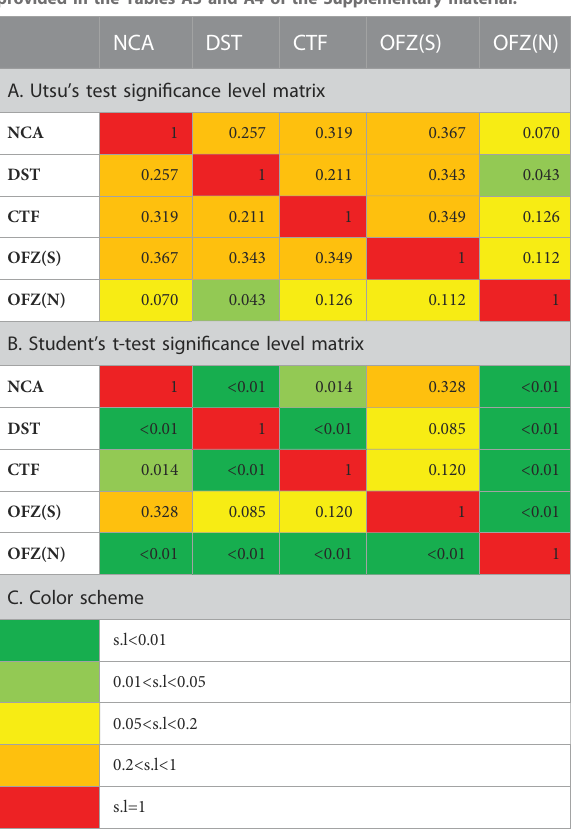
TABLE 4 Analysis of statistical signi fi cance for the Tectonic Zones, showing the signi fi cance level ( s . l .) matrices according to a) Utsu ’ s test; and b) the Student ’ s t-test. The statistical signi fi cance follows a color scheme (Table 4c) de fi ned by the range of s . l ., in which the green shades show